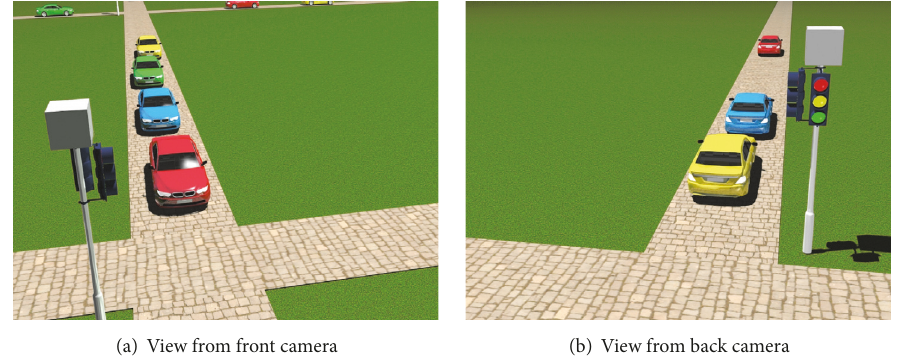
Figure 2: In the case of the self-organizing method, if a closed-loop system (CCTV) is used, a camera for each street where vehicles enter the intersection to detect approaching vehicles is required and a camera for every street is required where vehicles exit the intersection to detect vehicle dropout. From the images acquired, an algorithm recognizes vehicles approaching and leaving the intersection.